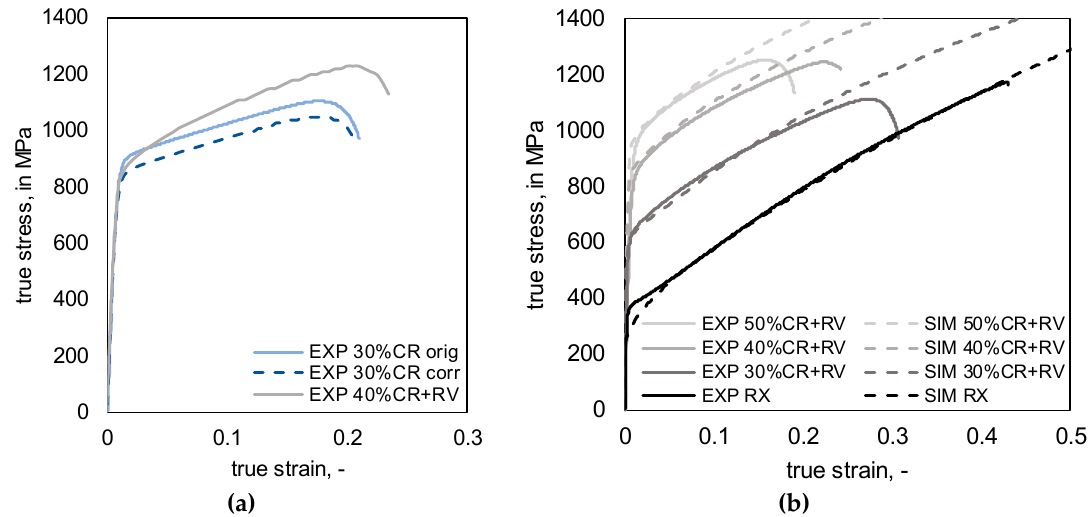
Figure 3. ( a ) True stress–strain curves of 30% CR and 40% CR + RV from experiments with similar yield strength but different hardening behavior with original data from tensile test (orig) and corrected data with offset (corr); ( b ) True stress–strain curves from tensile tests (EXP) and crystal plasticity (CP) simulation (SIM) of recovery annealed (RV) and recrystallized (RX) material conditions.